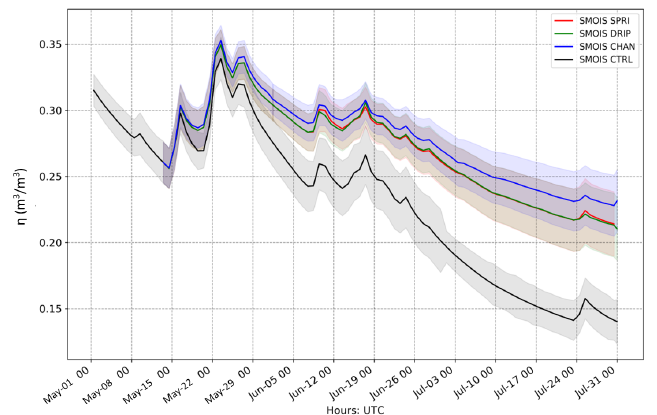
Figure 2. Temporal evolution of the diurnal average soil moisture first layer for all runs (control (CTRL), channel (CHAN), drip (DRIP), and sprinkler (SPRI)), averaged over the highlighted area of Figure 1b (red